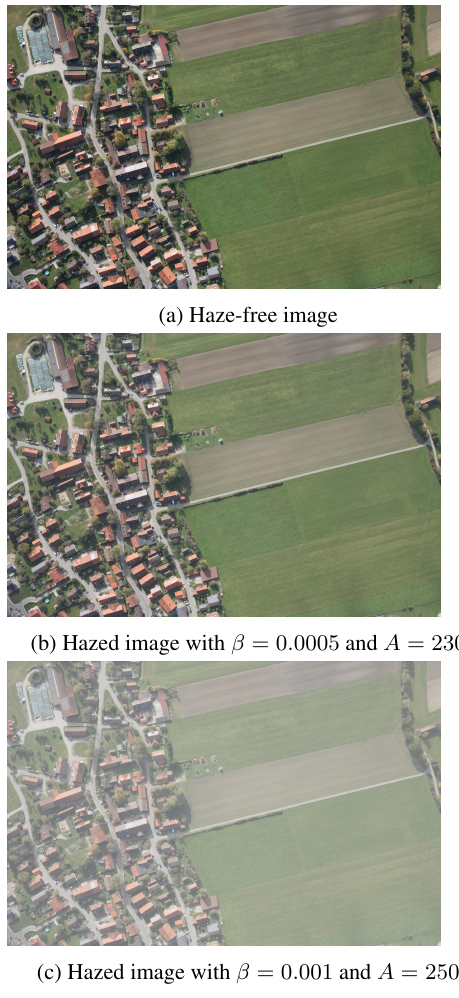
Figure 3: Synthetically and homogeneously hazed aerial image